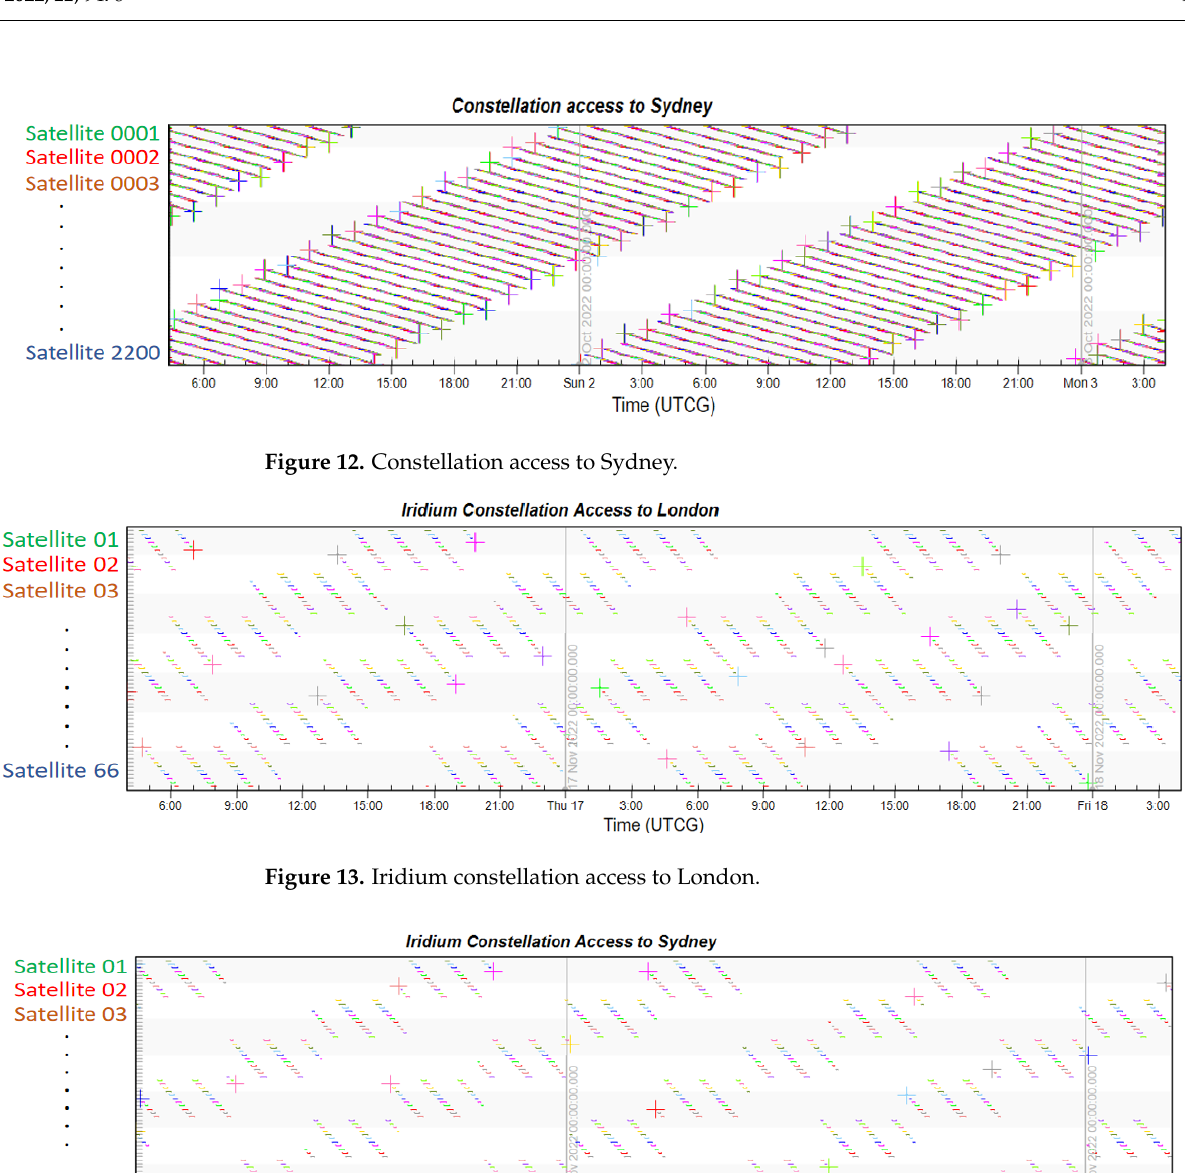
Figure 13. Iridium c onstellation access to London.